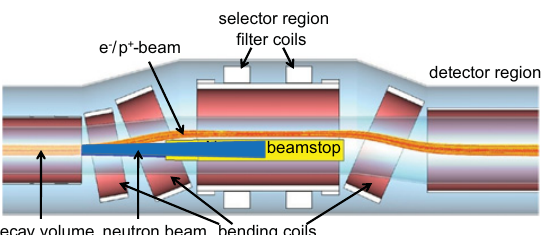
Figure 2. Close-up of the selector region: coils are drawn in red, simulated e − / p + -trajectories in orange. The remaining cold neutron beam (blue) coming from the left side is absorbed in the